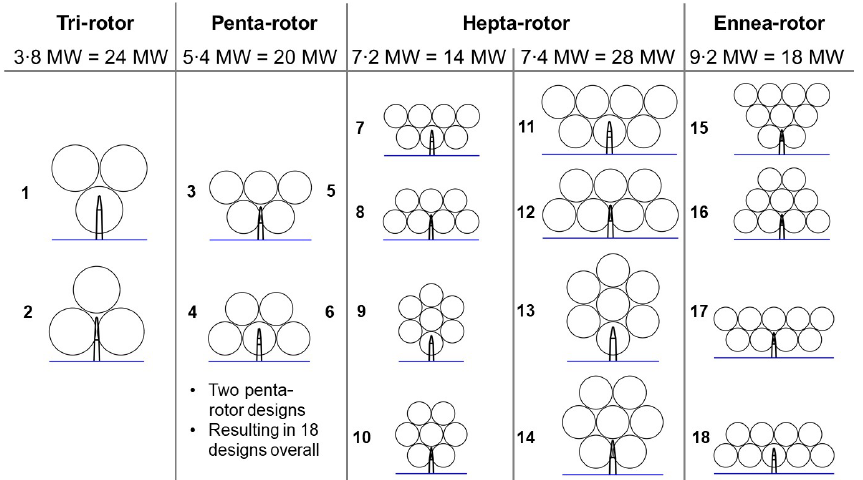
Figure 3. Overview and numbering of the SD-MRS designs.